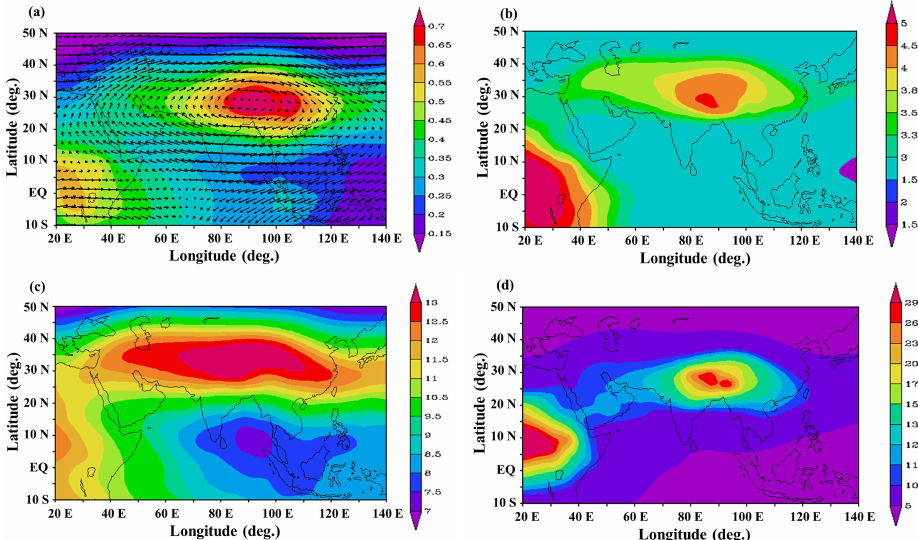
Fig. 1. Horizontal structure of June–September 2003 averages at 110hPa of aerosol concentrations (ngm − 3 ) : (a) BC and horizontal wind fields (shown as vectors), (b) OC, (c) SO 2 − , and (d) mineral 4